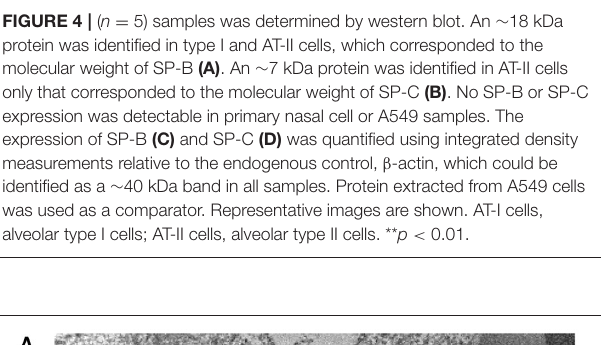
FIGURE 4 | ( n = 5) samples was determined by western blot. An ∼ 18 kDa protein was identified in type I and AT-II cells, which corresponded to the molecular weight of SP-B (A) . An ∼ 7 kDa protein was identified in AT-II cells only that corresponded to the molecular weight of SP-C (B) . No SP-B or SP-C expression was detectable in primary nasal cell or A549 samples. The expression of SP-B (C) and SP-C (D) was quantified using integrated density measurements relative to the endogenous control, β -actin, which could be identified as a ∼ 40 kDa band in all samples. Protein extracted from A549 cells